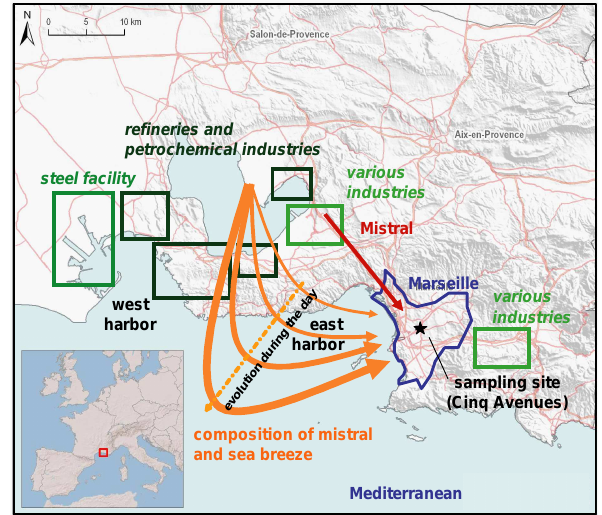
Fig. 1 Fig. 1. Location of the sampling site (Cinq avenues) and major nearby industrial facilities and simplified illustration of the main wind circulations (Mistral and land and sea